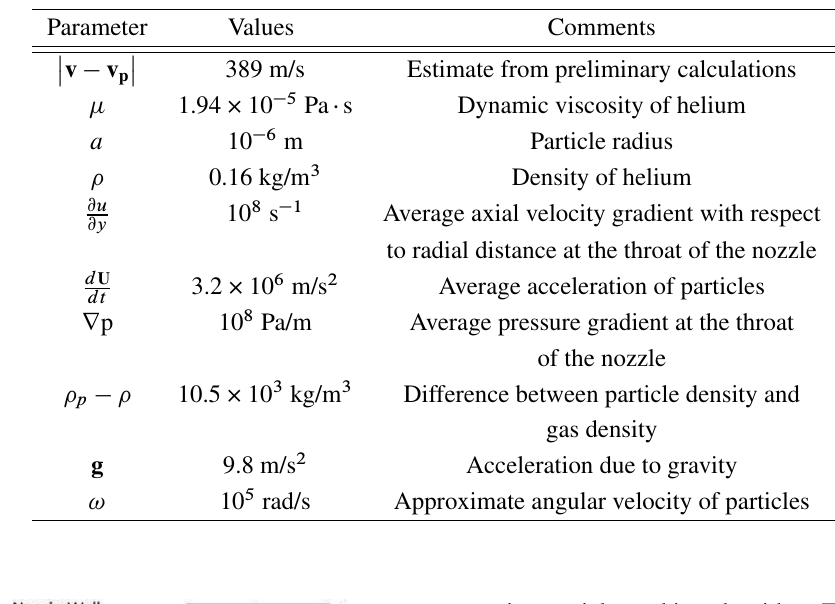
Table 1. Parameters for aerosol flow simulation.